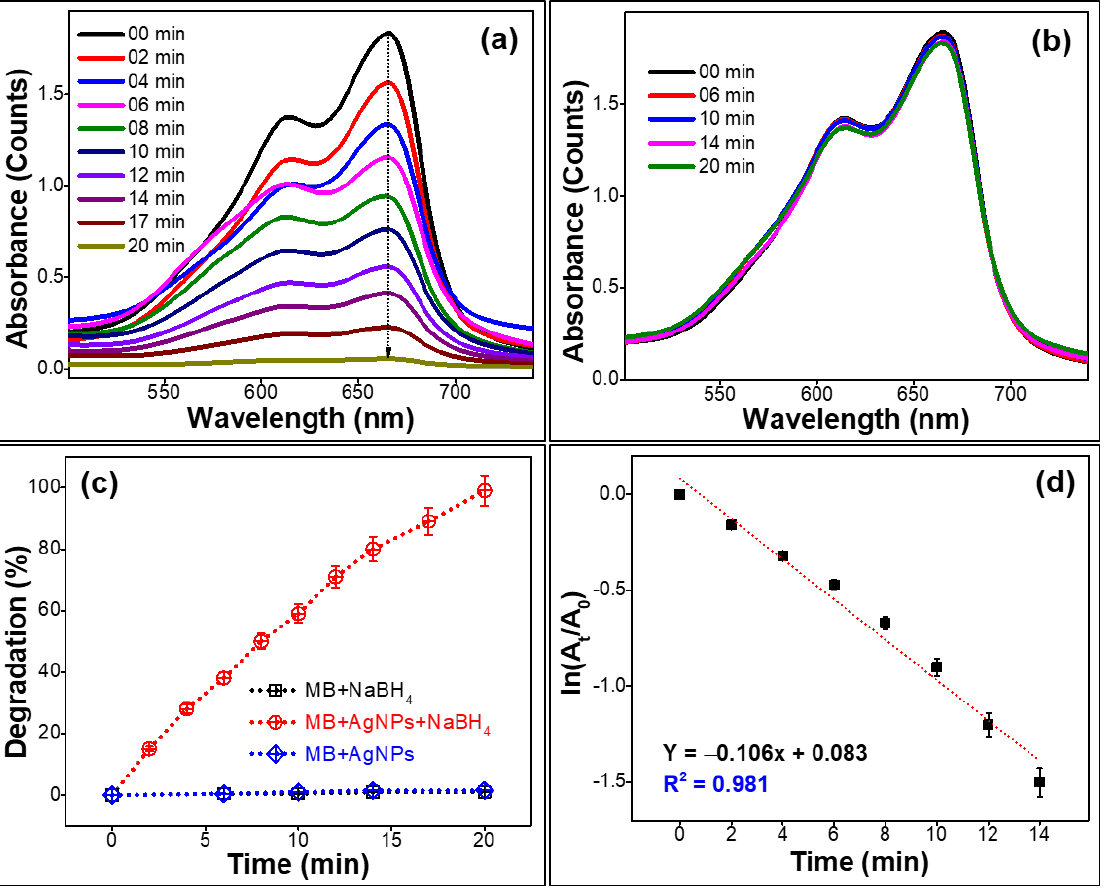
Figure 6. Degradation studies. ( a ) UV-vis absorbance of methylene blue with prepared silver nanoparticles and NaBH 4 at different reaction times, ( b ) UV-vis absorbance of methylene blue with prepared AgNPs at different reaction time ( c ) degradation efficiency (%) of silver nanoparticles towards the methylene blue, and ( d ) pseudo-first-order kinetic plot for the degradation of methylene blue.